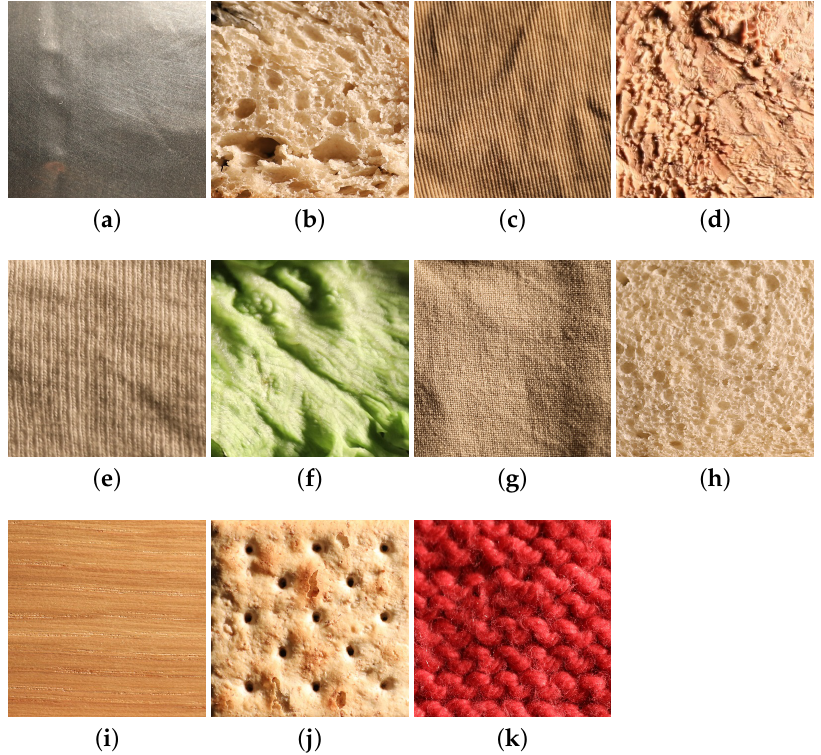
Figure 7. Images of samples of ( a ) aluminium foil, ( b ) brown bread, ( c ) corduroy, ( d ) cork, ( e ) cotton, ( f ) lettuce leaf, ( g ) linen, ( h ) white bread, ( i ) wood, ( j ) cracker, and ( k ) wool from the UJM-TIV dataset taken under illumination conditions of 65° and viewing condition